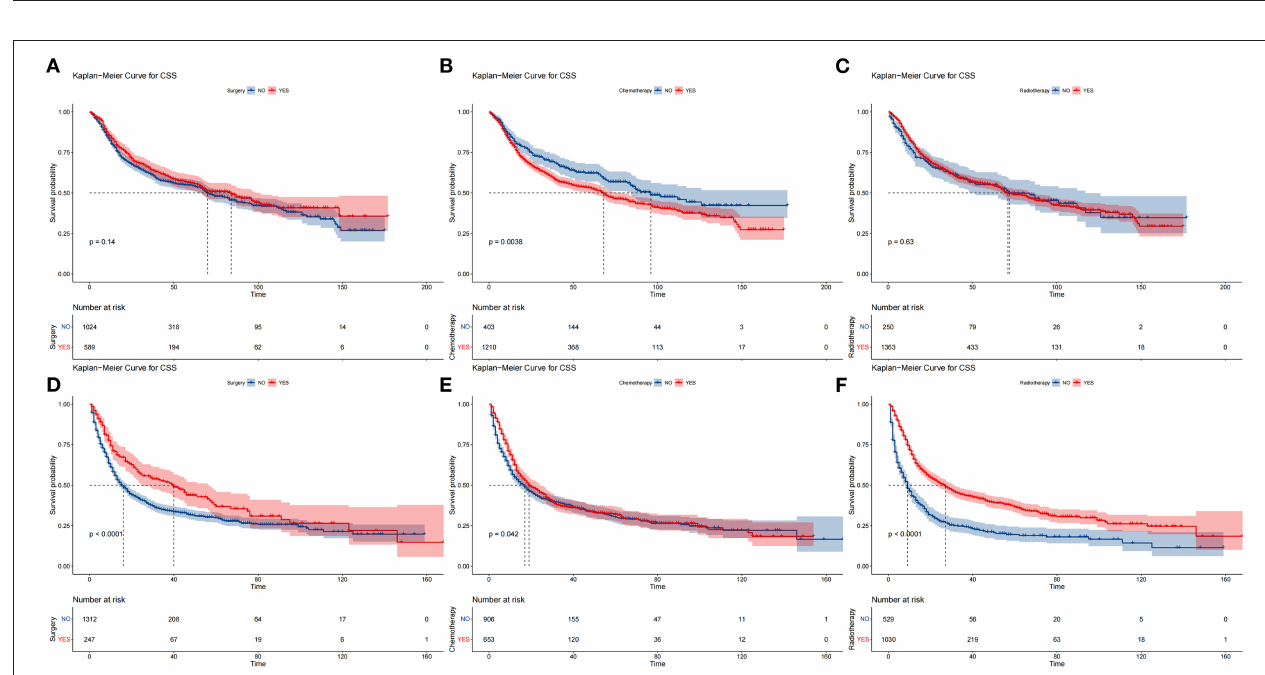
FIGURE 7 | Comparison of different surgical methods of Kaplan–Meier curves. Patients with or without surgery, chemotherapy, and radiation in the low-risk group (A–C) and high-risk group (D–F) .